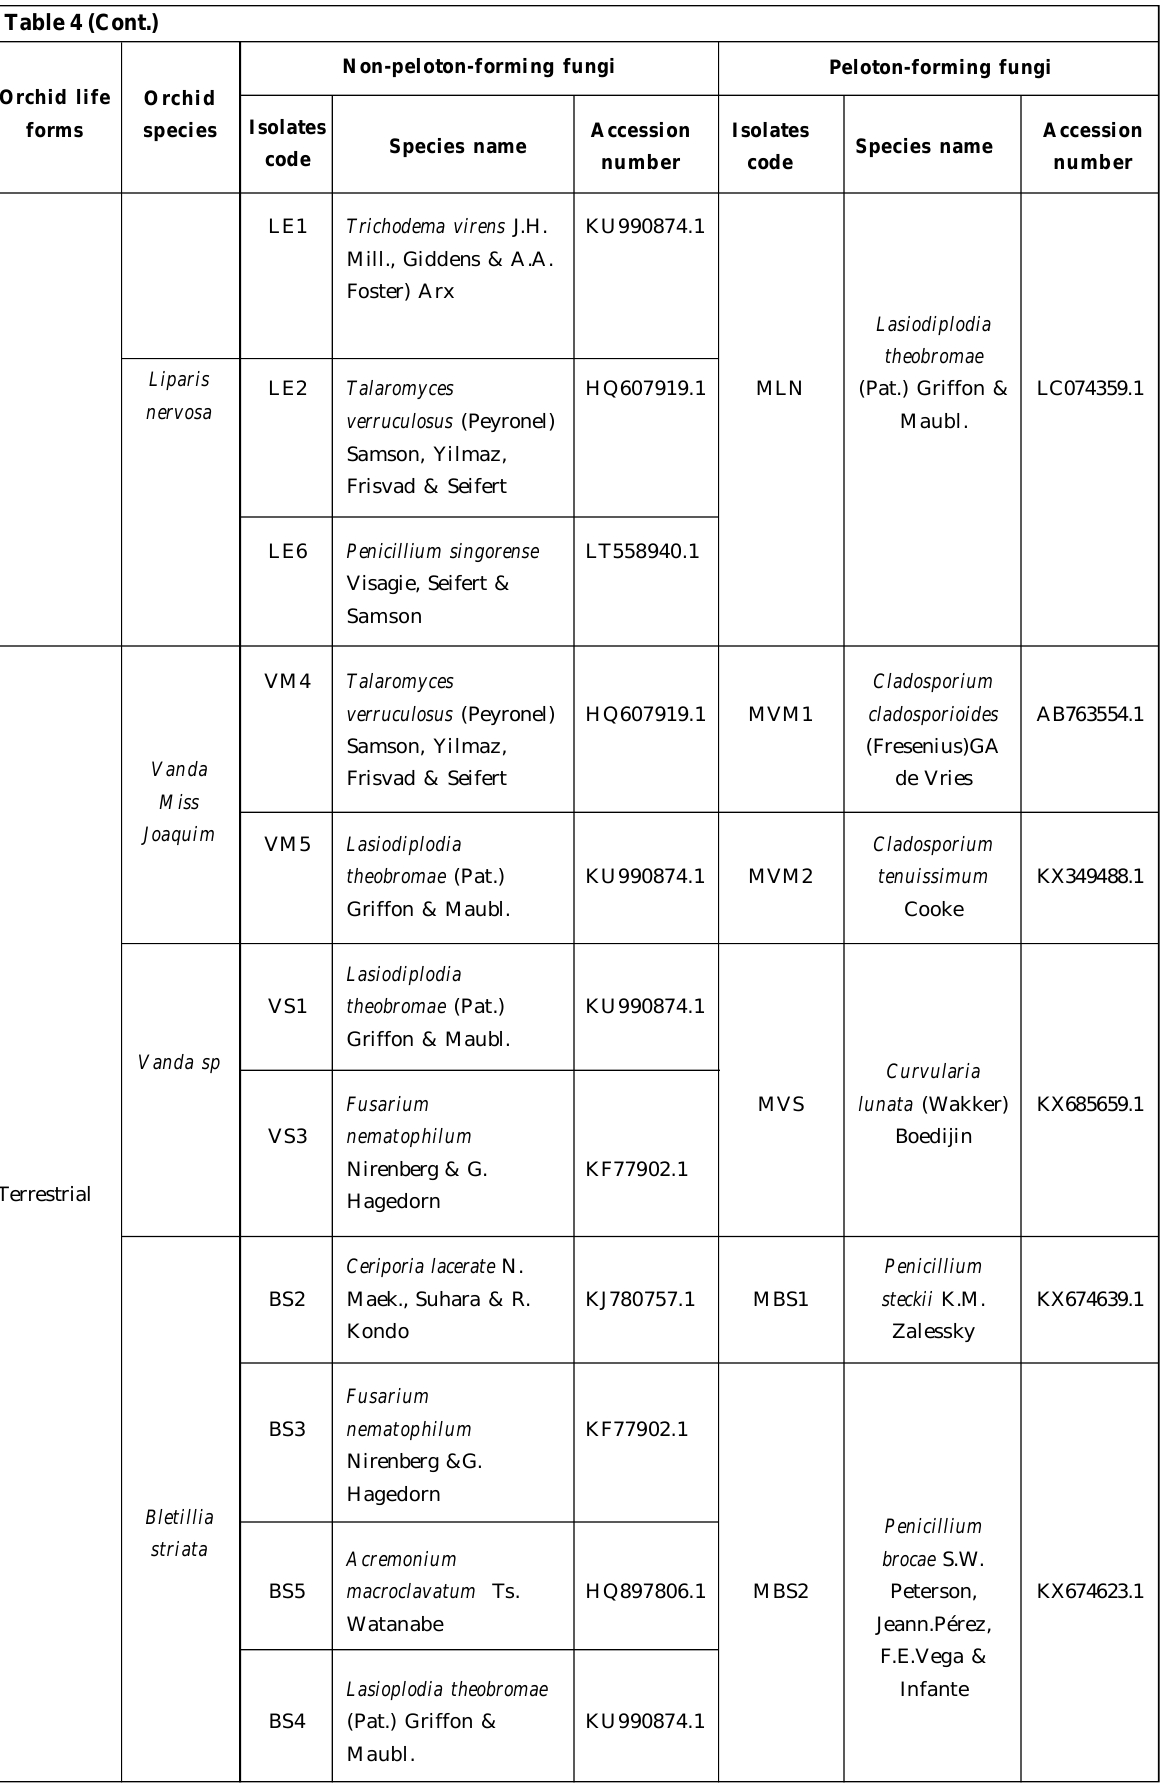
Table 4 (Cont.) Orchid life forms